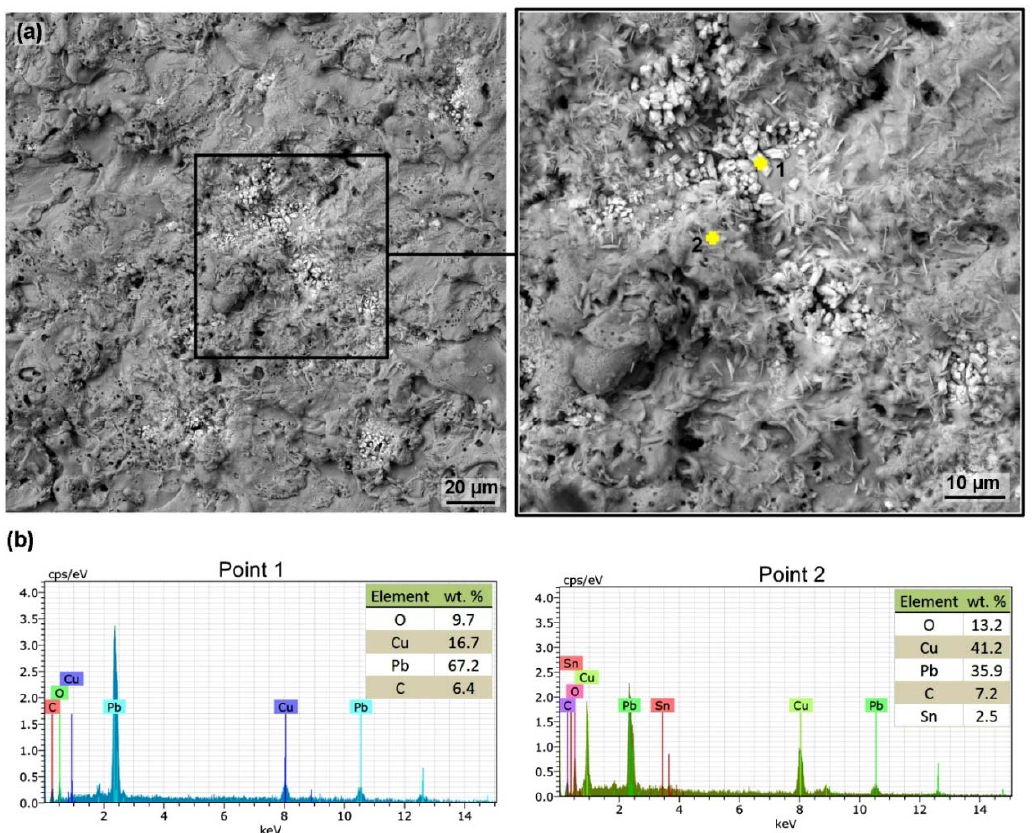
Figure 7. Surface morphology of Sample 20 with the lowest surface topography values machined with parameters: U = 70 V, T on = 6 µ s, T o ff = 50 µ s, v = 14 m · min − 1 and I = 25 A, SEM (BSE) including the detail and chemical composition analysis at two points ( a ) sample surface, ( b ) chemical composition analysis at Points 1 and 2.